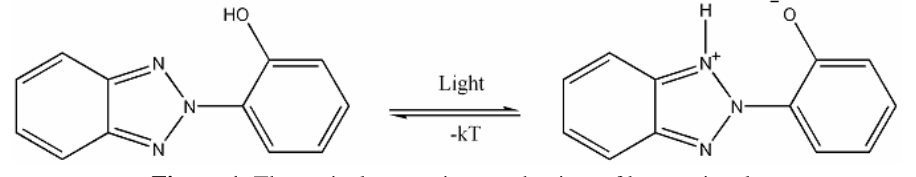
Figure 1. The typical protection mechanism of